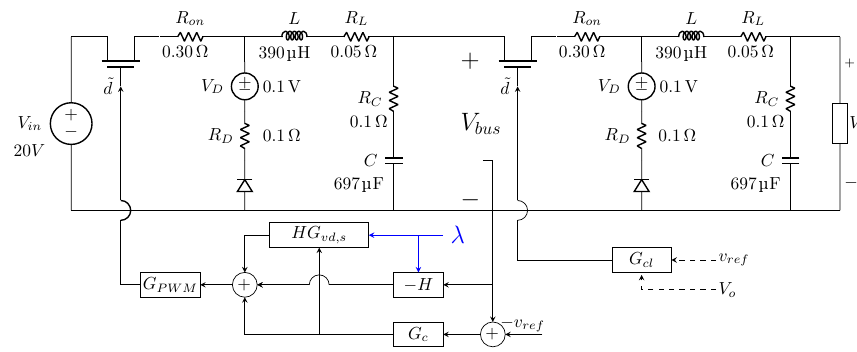
Figure 8. The prototype cascaded system used for analysis, simulation, and experiment.